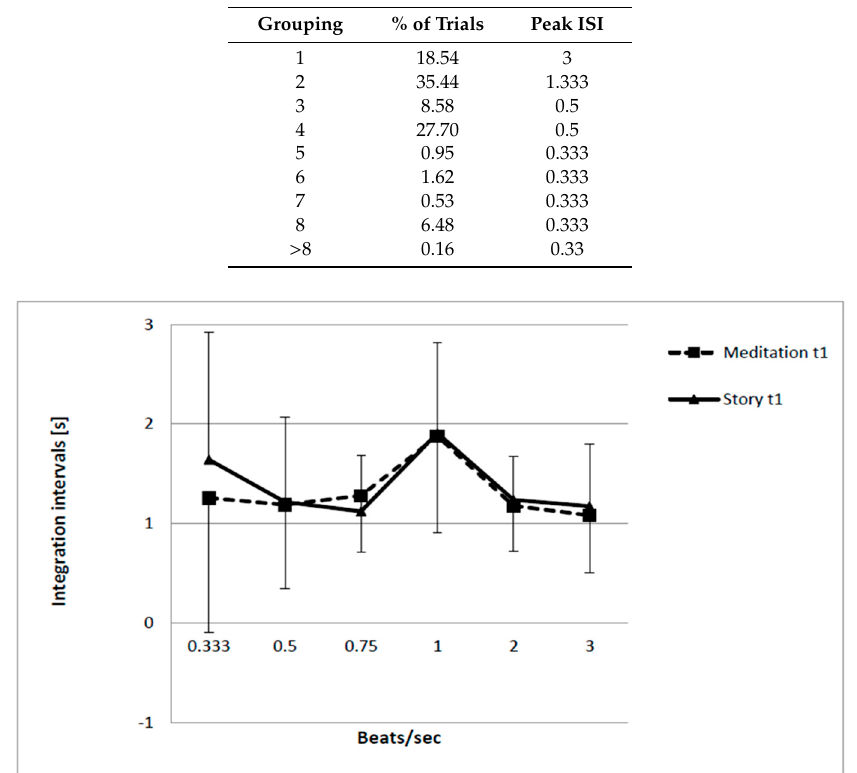
Figure A1. Perceived beats (integration interval) as a function of the metronome frequency (beats / sec) before meditation (t1).